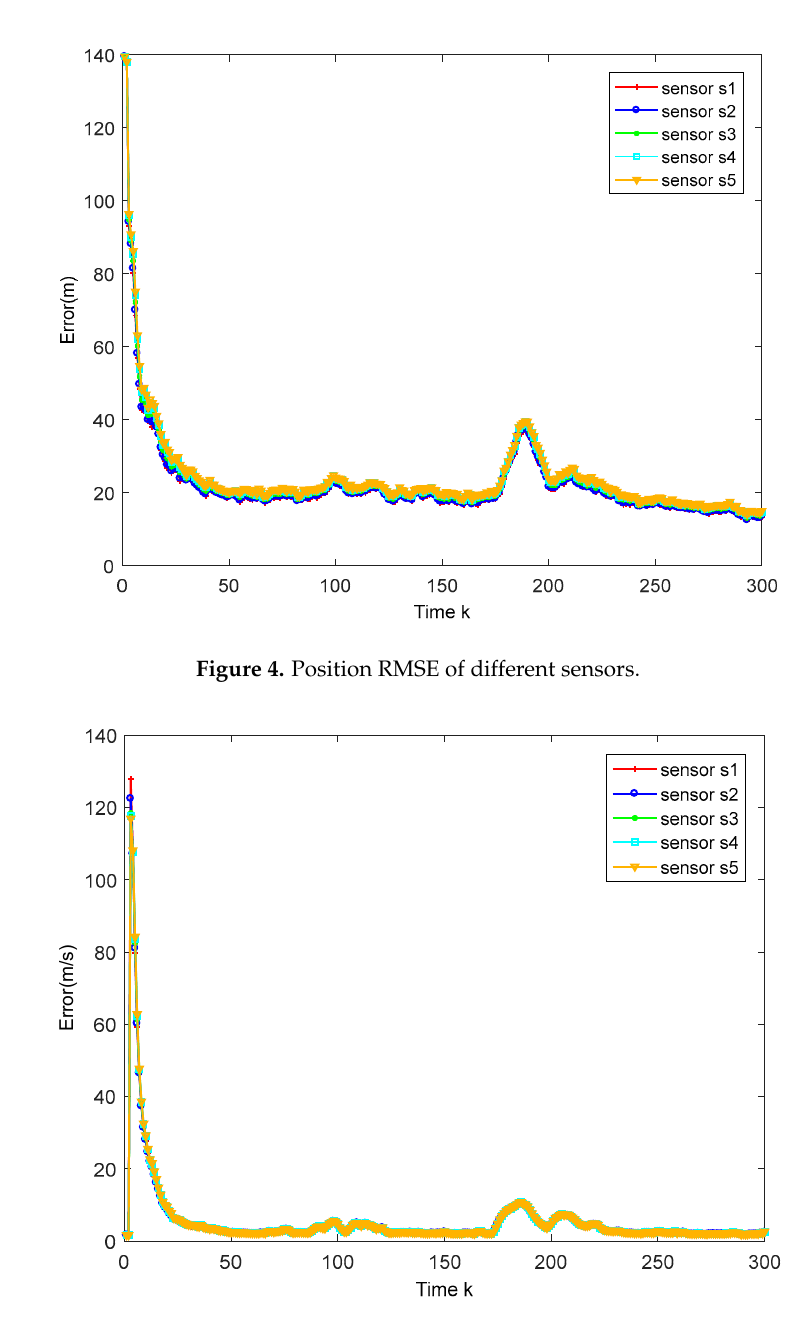
Figure 5. Velocity RMSE of different sensors.